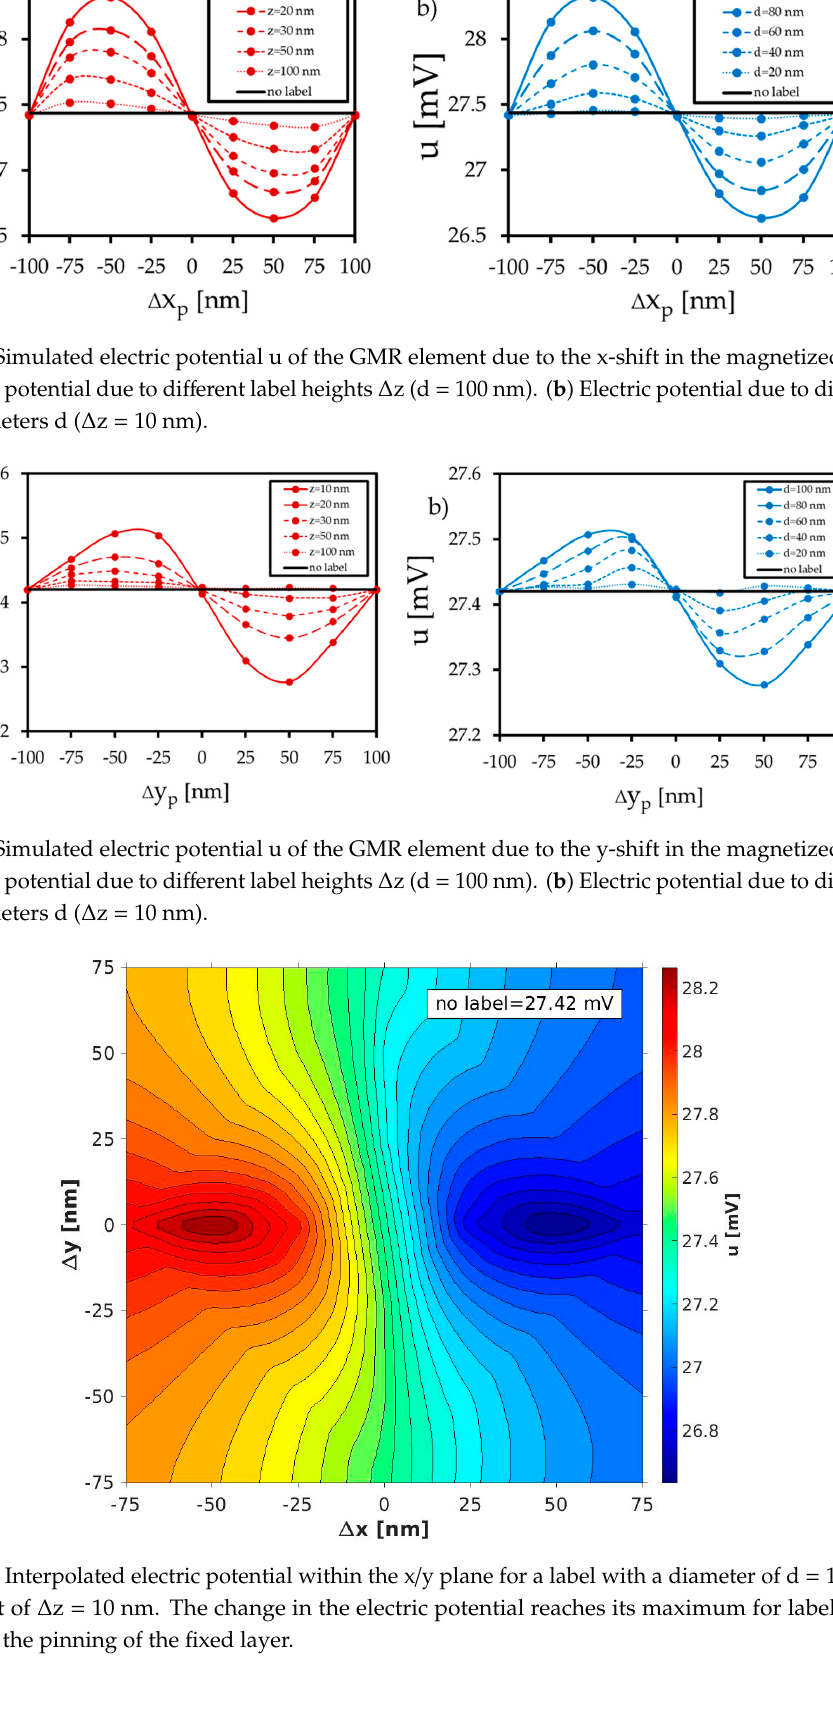
Figure 10. Interpolated electric potential within the x/y plane for a label with a diameter of d = 100 nm at a height of ∆ z = 10 nm. The change in the electric potential reaches its maximum for label shifts parallel to the pinning of the fixed layer.